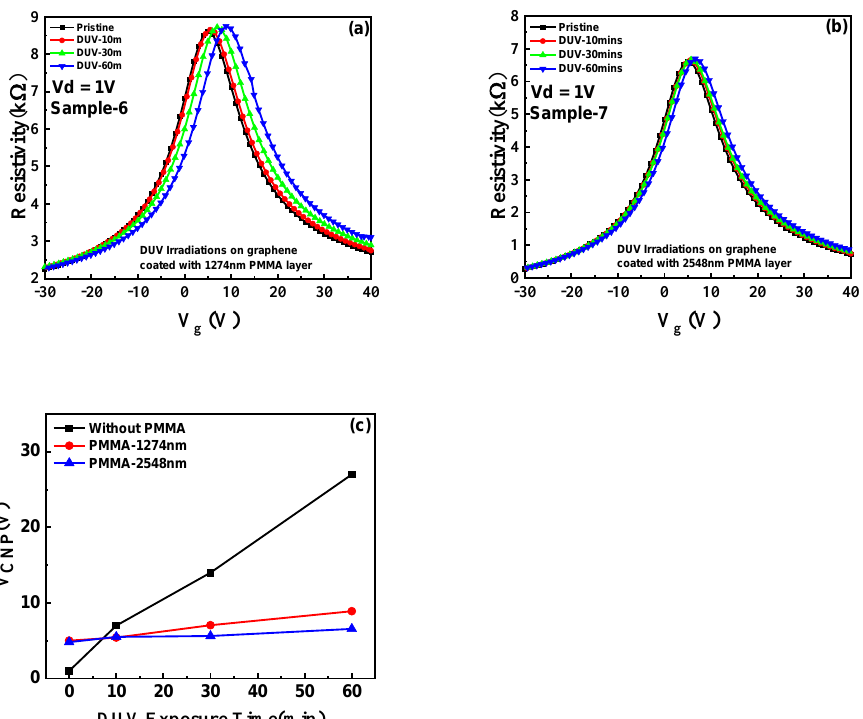
Figure 6. DUV effect on PMMA coated graphene: ( a ) Resistivity as a function of back-gate voltage (V g ) for sample-6 (1274nm PMMA layer coated graphene) showing a minor shift in CNP with increased DUV exposure time. ( b ) Resistivity as a function of back-gate voltage (V g ) for sample-7 (3548 nm PMMA layer coated graphene), exhibiting a negligible shift in CNP with increased DUV exposure time. ( c ) A shift in the charge neutrality point voltages (V CNP ) for devices coated without a PMMA layer, 1274 nm PMMA layer, and 2548 nm PMMA layer. The device with a 2548 nm PMMA- coated layer exhibited a negligible shift in the CNP position, confirming no DUV effect on graphene.